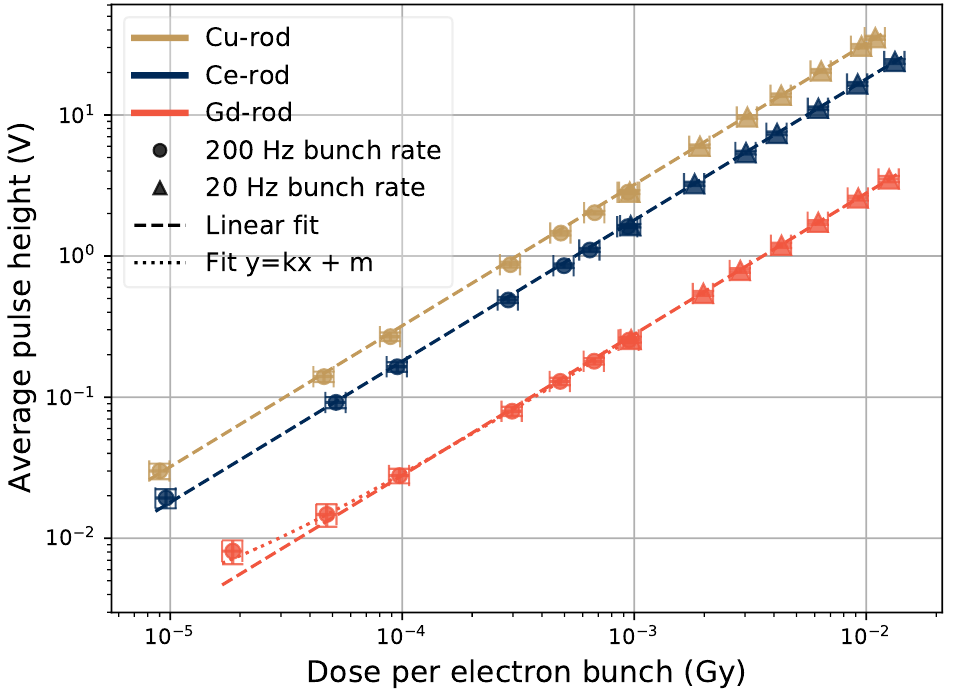
Figure 7. Pulse height as a function of electron bunch size in the different samples. The average pulse height is shown for electron bunch rates of 20 Hz and 200